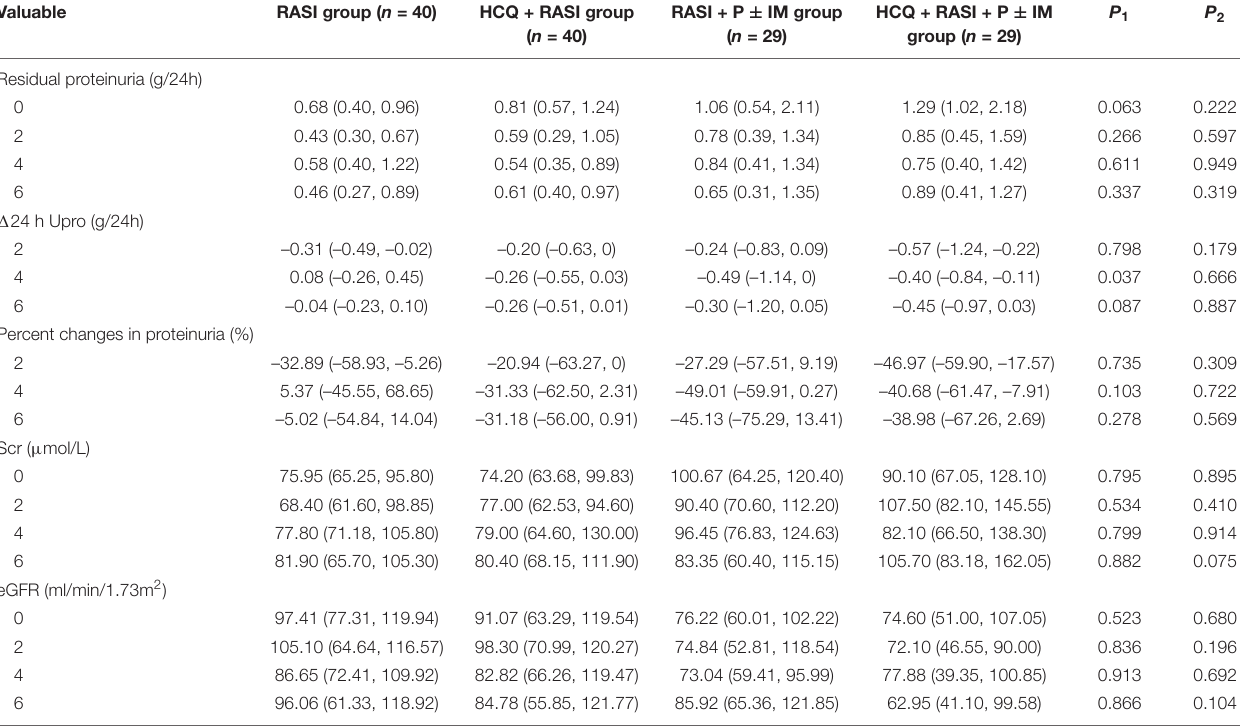
Figure 4 . At the 6 months, the cumulative frequency of residual proteinuria remission in the HCQ + RASI group was